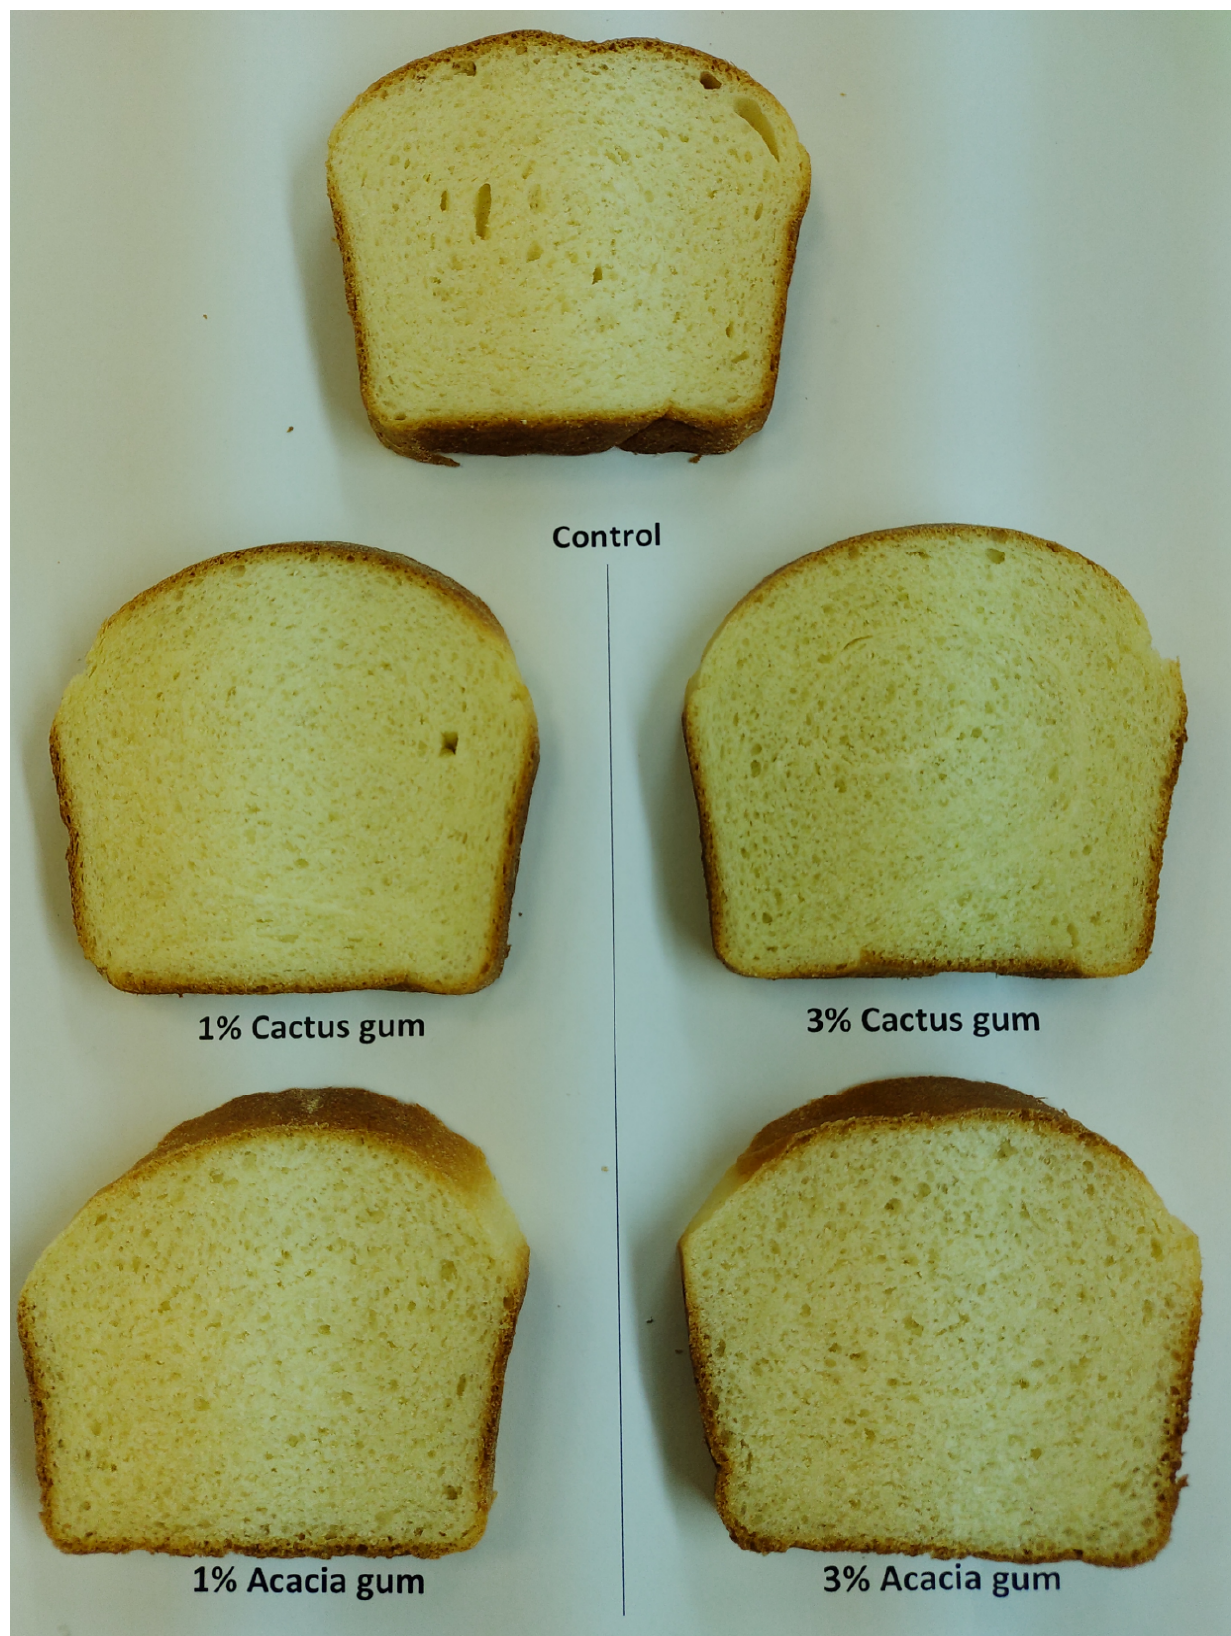
Figure 2. Images of the central slices of the different breads containing acacia and cactus gums.